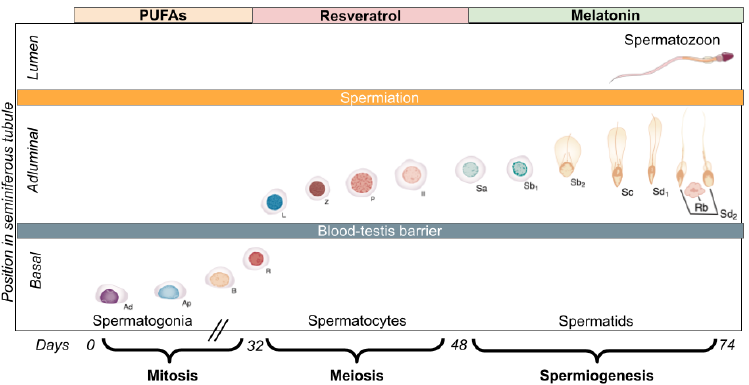
Figure 3. Timeframes in human spermatogenesis and proposed antioxidant intervention. Ad, Dark type A spermatogonium; Ap, pale type A spermatogonium; B, type B spermatogonium; II, secondary spermatocyte; L, leptotene spermatocyte; P, pachytene spermatocyte; R, resting or preleptotene primary spermatocyte; Rb, residual body; Sa (a), Sb1 (b1), Sb2 (b2), Sc (c), Sd1 (d1), Sd2 (d2), spermatids; Z, zygotene spermatocyte. (Adapted from Servier Medical Art; Campbell-Walsh-Wein Urology, Part VI: Reproductive and Sexual Function, page 1398; and Henry TD, Porucznik